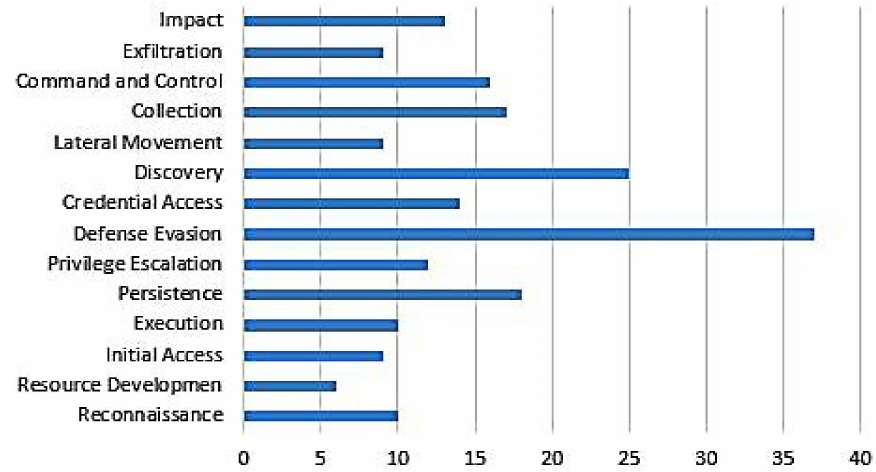
Figure 6. Cybersecurity Techniques according to MITRE.